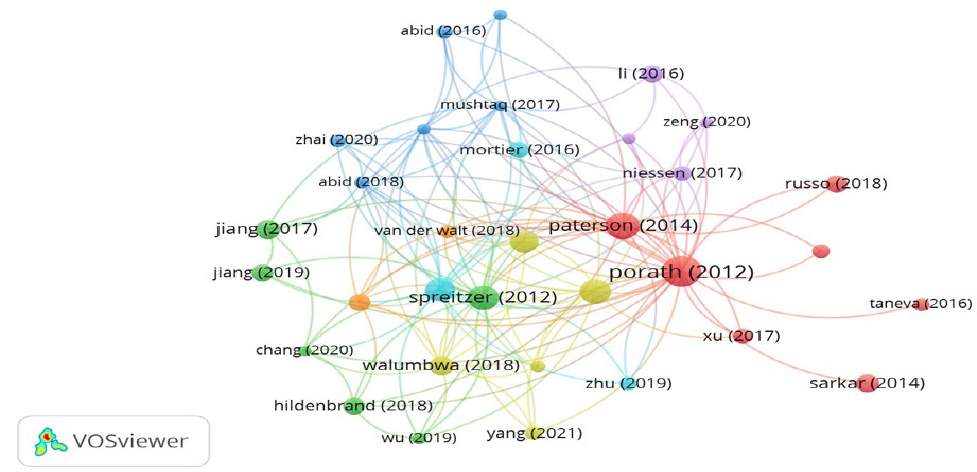
Figure 5. Bibliometric map of authors of the most-cited articles and links between them.